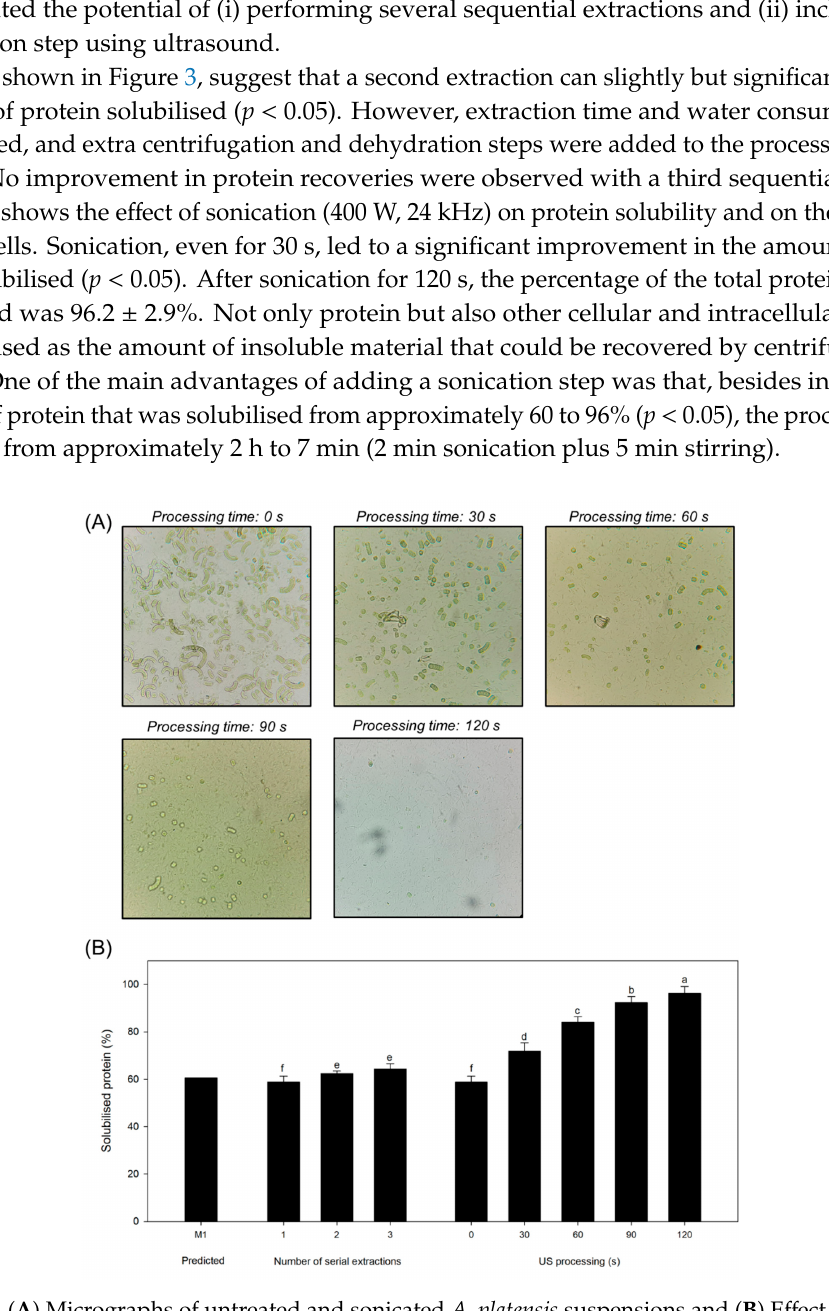
Figure 3. ( A ) Micrographs of untreated and sonicated A. platensis suspensions and ( B ) Effect of serial extractions and sonication on protein solubilisation. Values represent the mean of three independent determinations ± SD. Different letters indicate significant differences. The criterium for statistical significance is p < 0.05. significance is p <